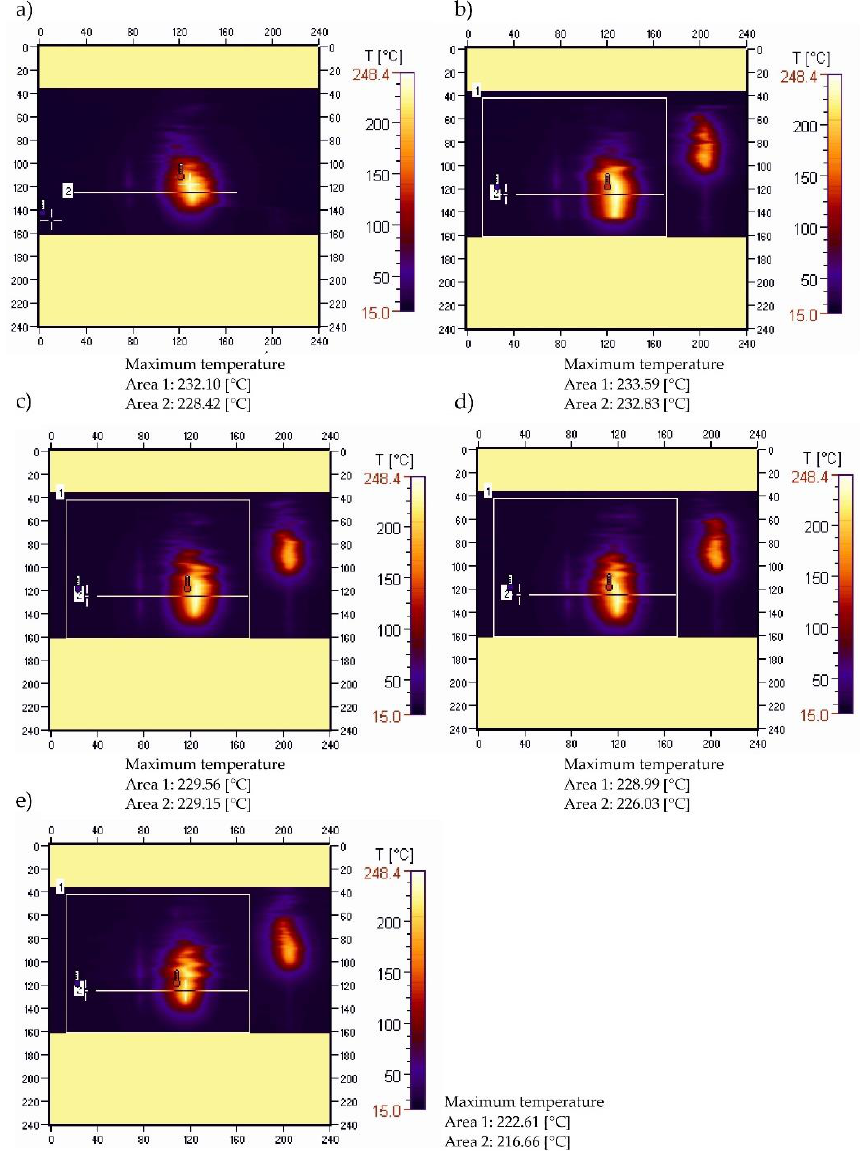
Figure 3. Thermograms of PE50 sample recorded during ignition ( a ) and after: ( b )—15, ( c )—30, ( d )—45, ( e )—60 s after the ignition source was removed.